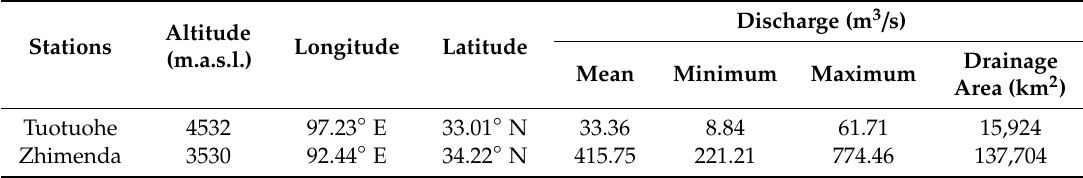
Table 2. Observation stations with mean, maximum, and minimum streamflow in the headwaters of the Yangtze River (HYWZ) during 1961–2015.